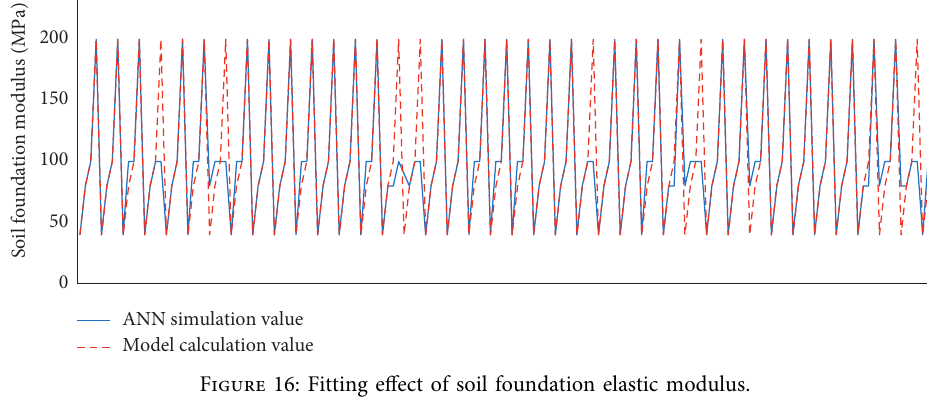
Figure 16: Fitting effect of soil foundation elastic modulus.